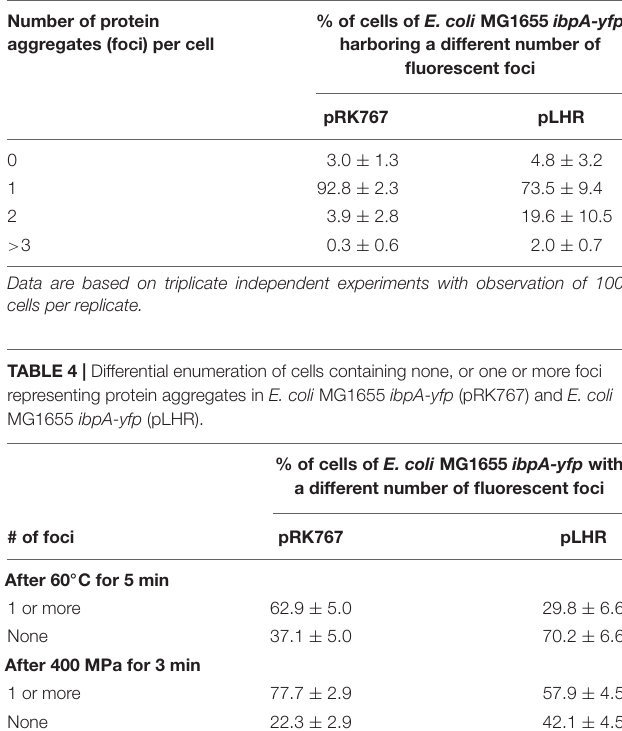
% of cells of E. coli MG1655 ibpA-yfp harboring a different number of fluorescent foci pRK767